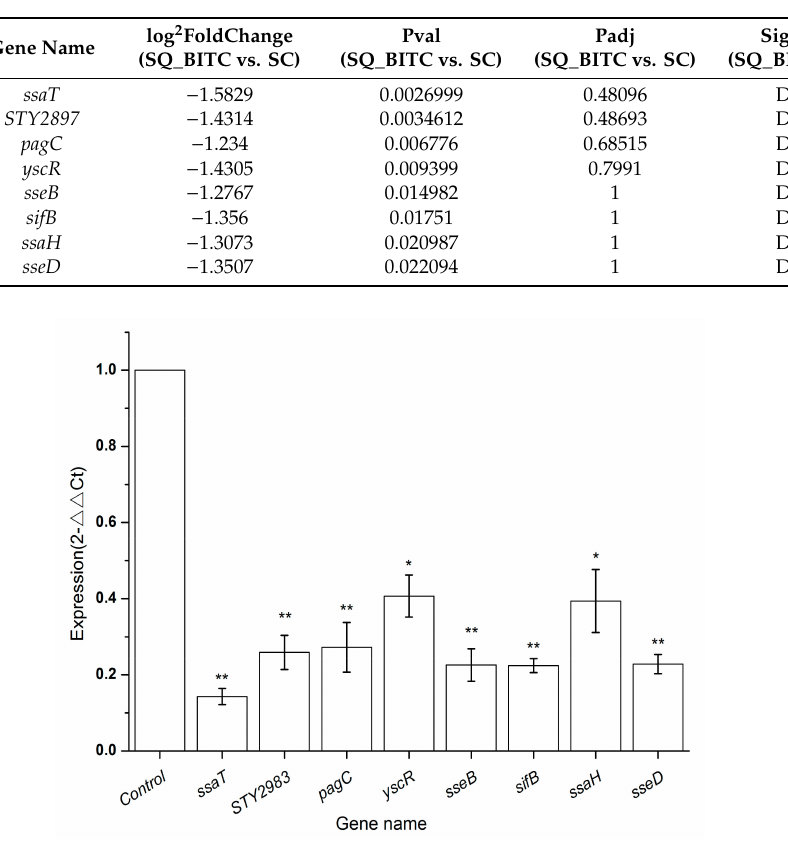
Figure 3. The most abundant pathways for a total of 197 di ff erentially expressed genes. The size of the dot is proportional to the number of genes; the closer the q value is to 0, the greater the extent of enrichment. Table 2. Data for the di ff erentially expressed genes.